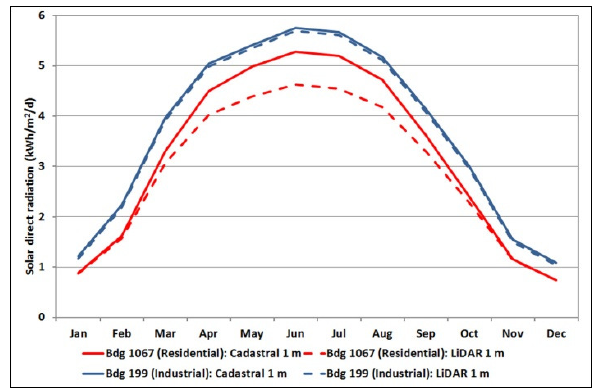
Figure 4 – Comparison between solar radiation results obtained for two different building classes. In case of